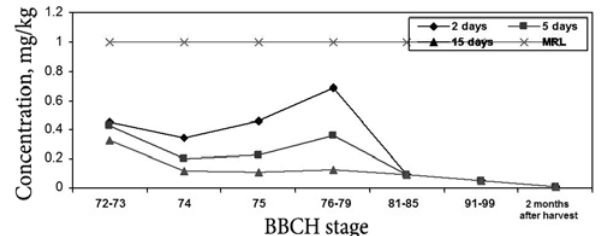
Fig. 14. Degradation of alpha-cypermethrin in Jonathan apples